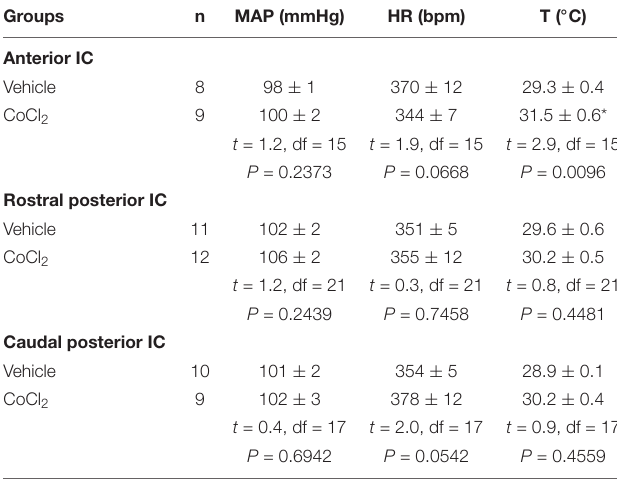
TABLE 1 | Basal parameters (i.e., pre-stress values) of mean arterial pressure (MAP), heart rate (HR), and tail skin temperature (T) after pharmacological treatment of either the anterior, rostral posterior, or caudal posterior regions of the insular cortex (IC) with the non-selective synaptic inhibitor CoCl 2 or vehicle. Groups